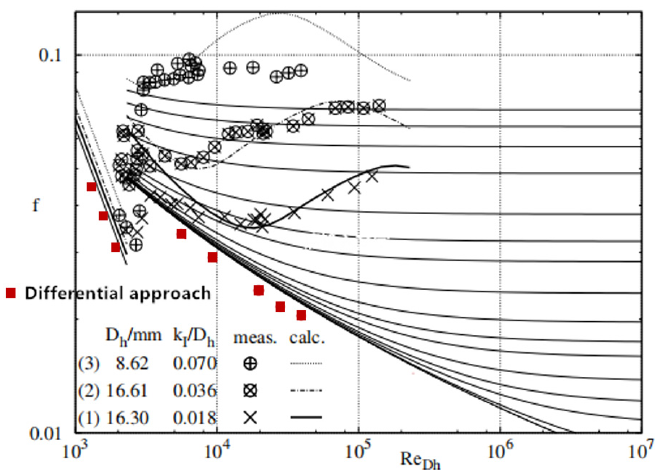
Figure 1. Moody chart comparing the results of differential approach with data from [3] and with experimental results.